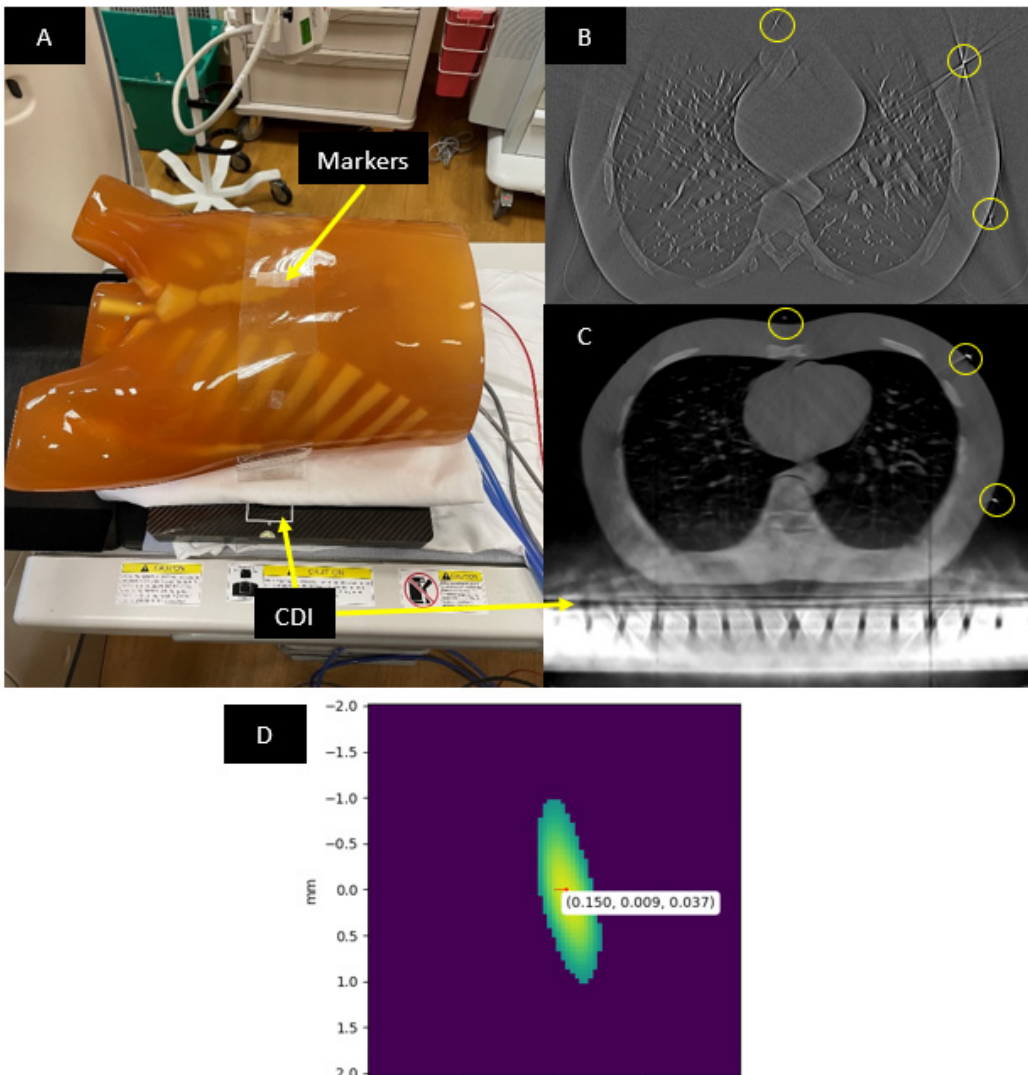
Figure 2. ( A ) The LUNGMAN phantom lying on the CDI with fiducial markers placed on the outer surface of the phantom. ( B ) Slice of the CDI’s reconstructed volume in the CT coordinate system. ( C ) The same slice in the CT images. Regions circled in yellow highlight visible fiducial markers. ( D ) Intensity profile of a marker bead in a CT image, after thresholding at half maximum intensity. The image was reconstructed at 50 µm pixel size. Center-of-mass of the profile is calculated as the location of a fiducial marker.